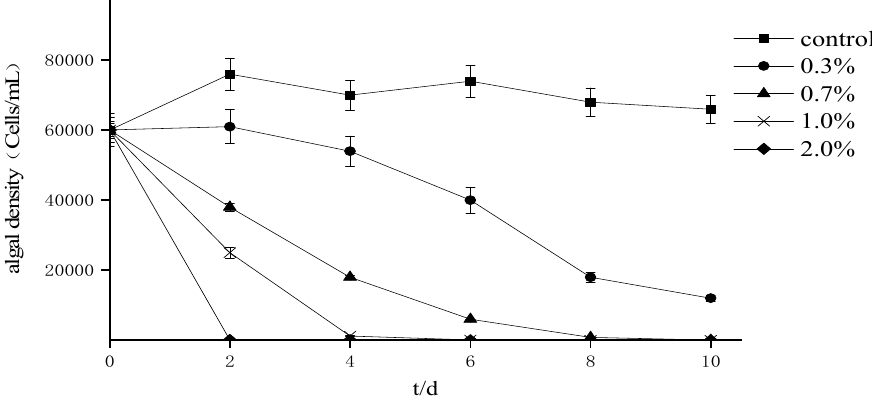
Figure 1. Effects of different proportions of fermentation broth on the growth of Alexandrium tamarense. The effects of fermentation broth with different supplemental levels on the growth of P. donghaiense (Figure 2) indicate that the density of algae cells decreases with the pro- longation of treatment time. Among the treatment groups, the changing trend for the 2% treatment group was faster than that for the other treatments, showing that the inhibition rate could reach 99.1% in two days. The results of the correlation analysis (Table 1) showed that treatment time and different supplemental levels had a significant correlation with the cell density of P. donghaiense ( p < 0.01), while different supplemental levels had a sig- nificant correlation with A. tamarense algal cell density ( p < 0.01).